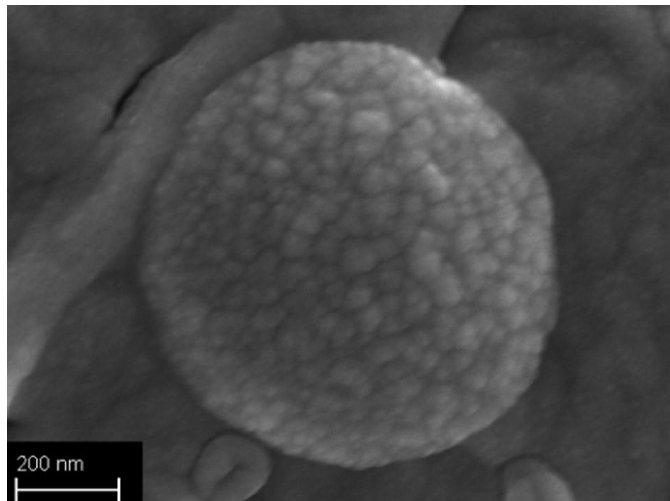
Figure 3. Field emission scanning electron microscopy (FESEM) image of nanoparticles (NPs) produced at 20 mL/min at 150,000X magnification for PCL-CAF 1.5 -Ac formulation.